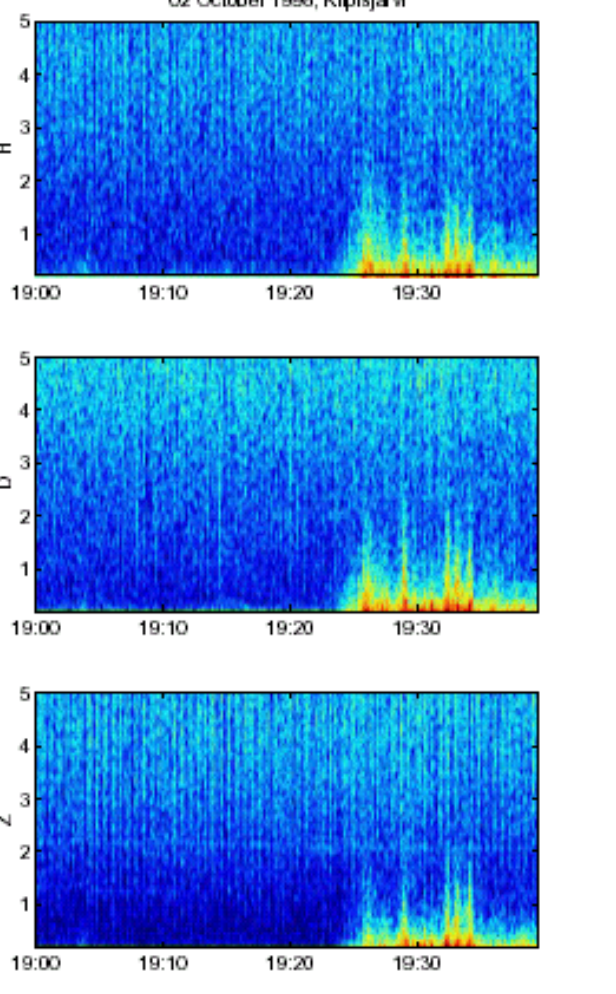
Fig. 5. H , D , and Z components of magnetic pulsations recorded at Kilpisjarvi on 2 October 1998, and their sonograms (dynamic frequency spectra) in the frequency range from 0.2 to 5 Hz.